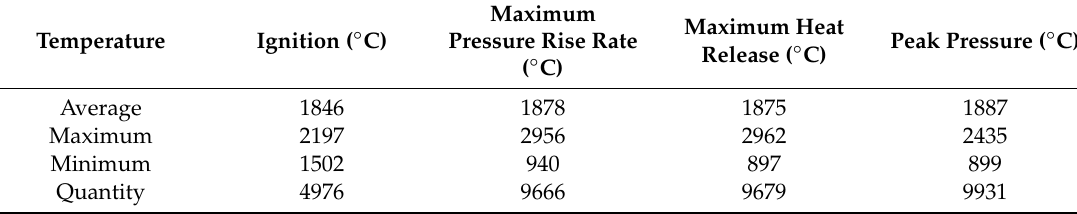
Table 4. Typical temperature of series 2 with CMS.